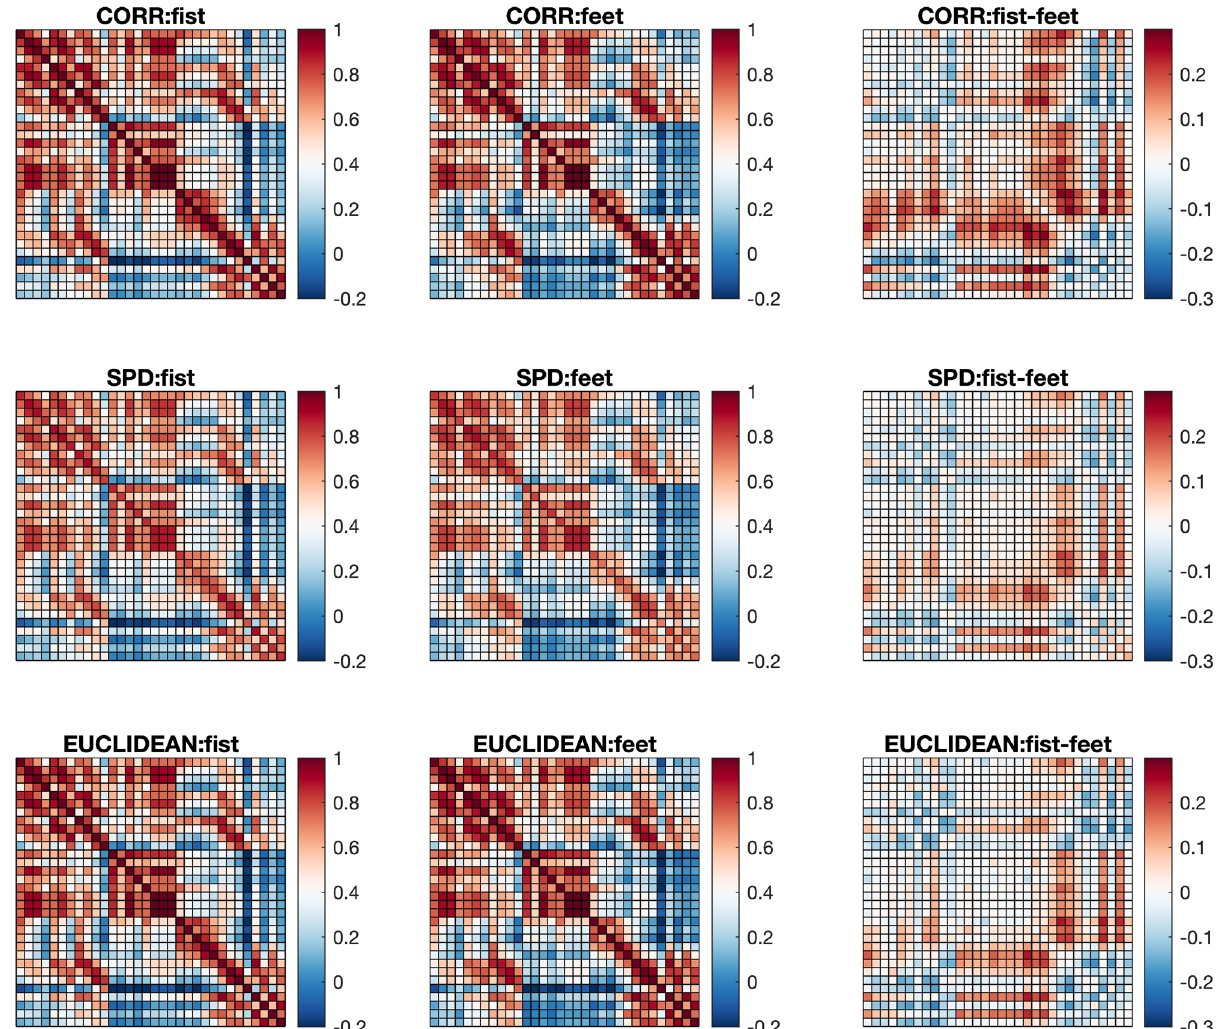
Figure 5. Fréchet mean of correlation matrices from fists and feet classes. Rows indicate a choice of geometric structure by viewing the matrices as elements of the correlation manifold (top), the SPD manifold (middle), and the Euclidean space (bottom). First two columns are Fréchet means for the fists and the feet classes, respectively. The last column is difference in Fréchet means of two classes.